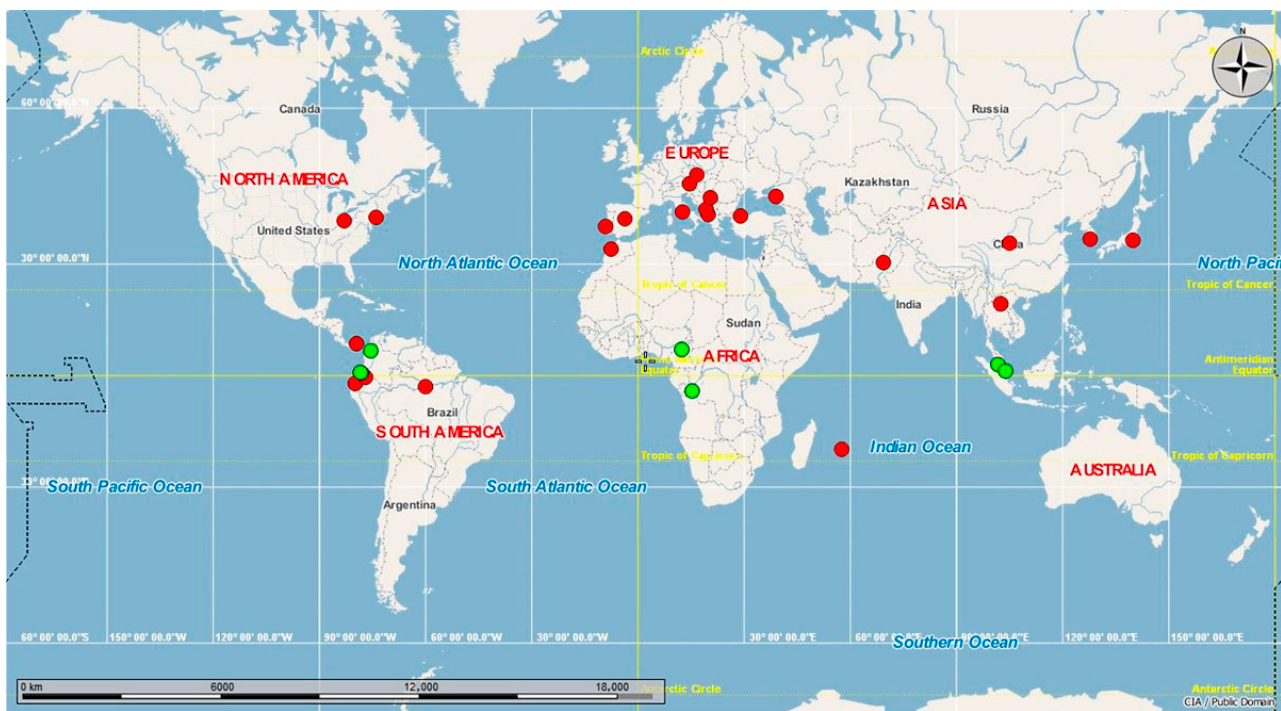
Figure 3. Global haplotype network. Worldwide distribution of Aedes albopictus haplotypes reported in Ecuador.